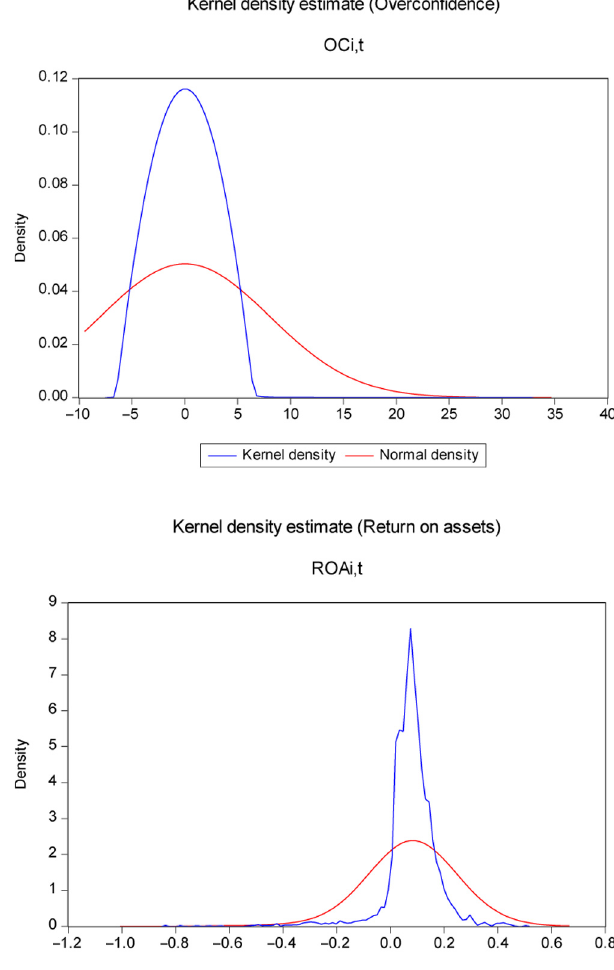
Figure 8. Non-normality of economic performance (industry